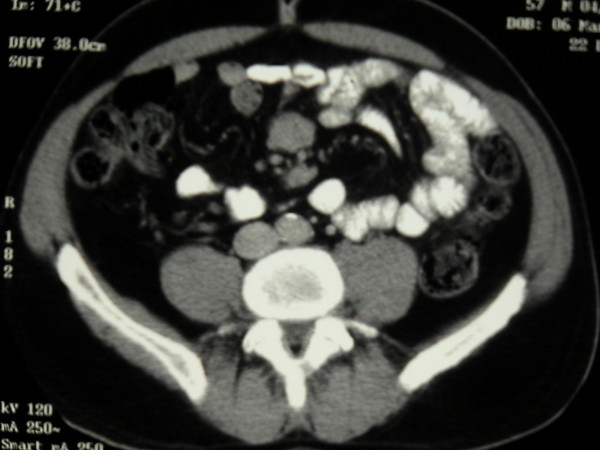
CT scan showing a mesenteric deposit of tumour metastases prior to chemotherapy with no apparent para aortic lymph node enlargement.